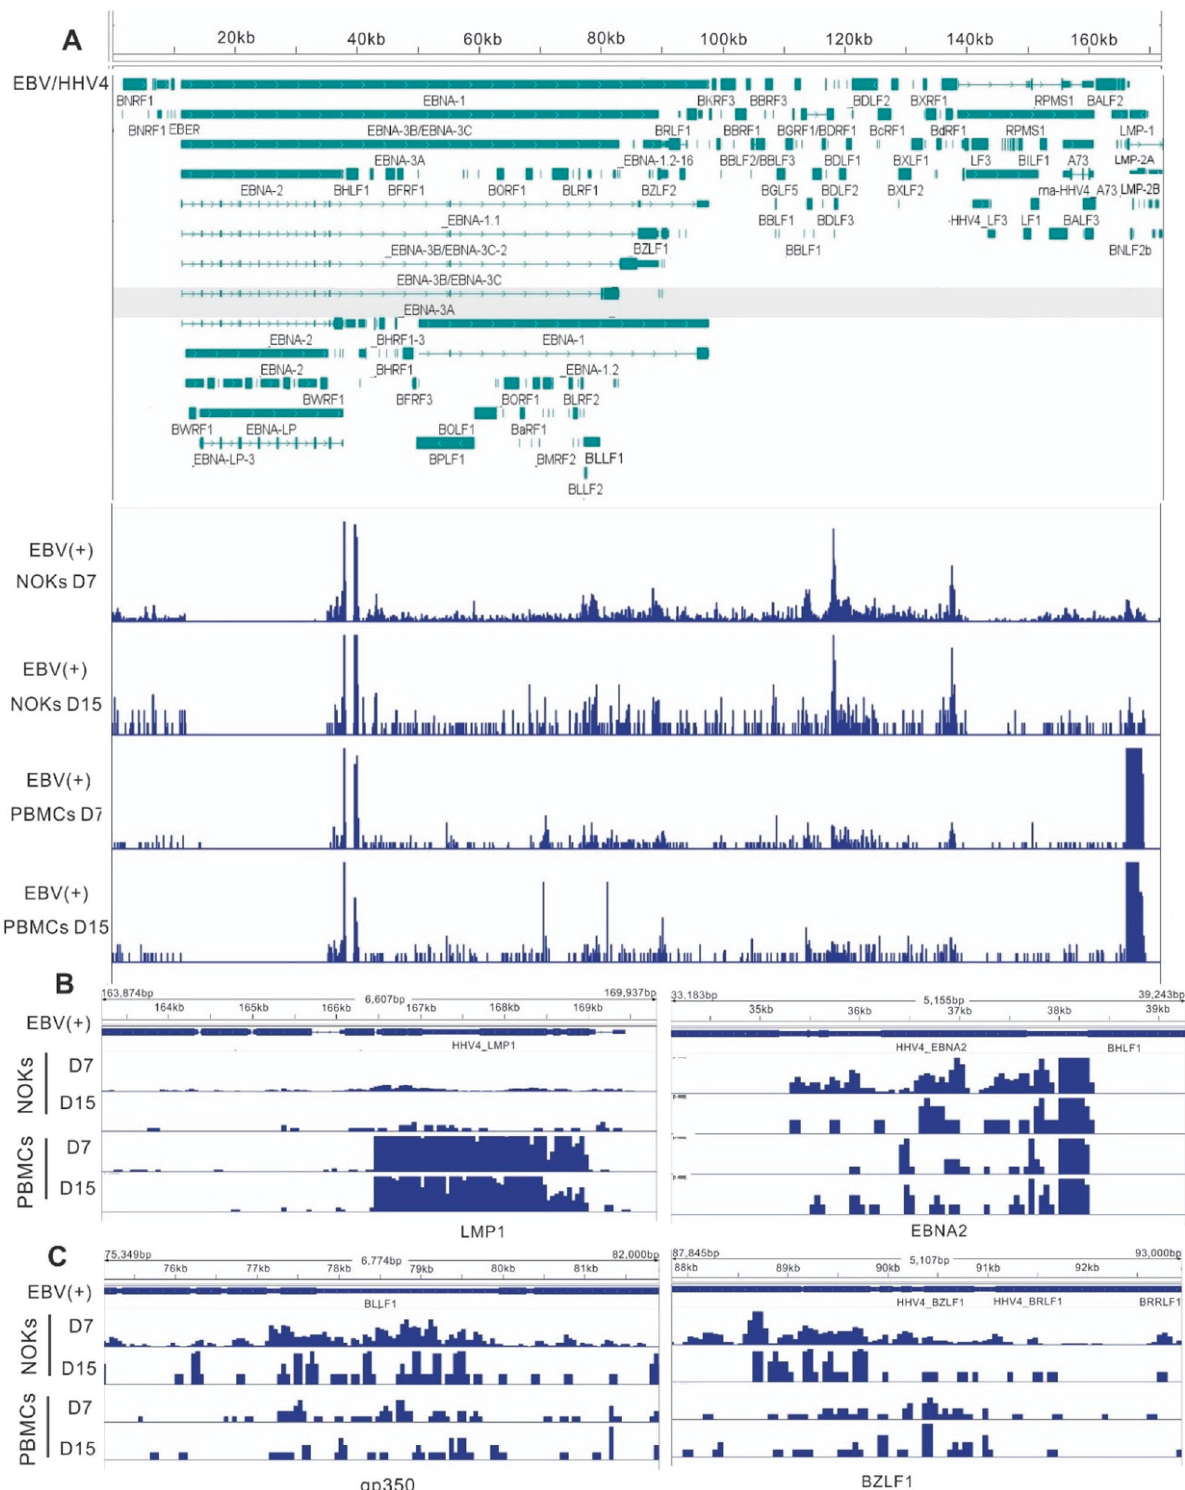
Fig. 2 Representative images of sequencing read mapped to EBV-encoded lytic and latent genes in EBV-infected PBMCs and NOKs. EBV RNA expression in NOKs compared to that observed in PBMCs. A RNA-seq data for infected NOKs and infected PBMCs at different days mapped to the wild-type EBV genome. Genes corresponding to observed signals are indicated below the tracks. The RNA-seq data image shows that most EBV genes were differentially expressed in NOKs and PBMCs. B Zoom in of regions, EBV latent gene LMP1 and EBNA2 from RNA sequencing data shows more detail peaks. C Zoom in of regions, EBV lytic gene gp350 and BZLF1 from RNA sequencing data shows more detail peaks.